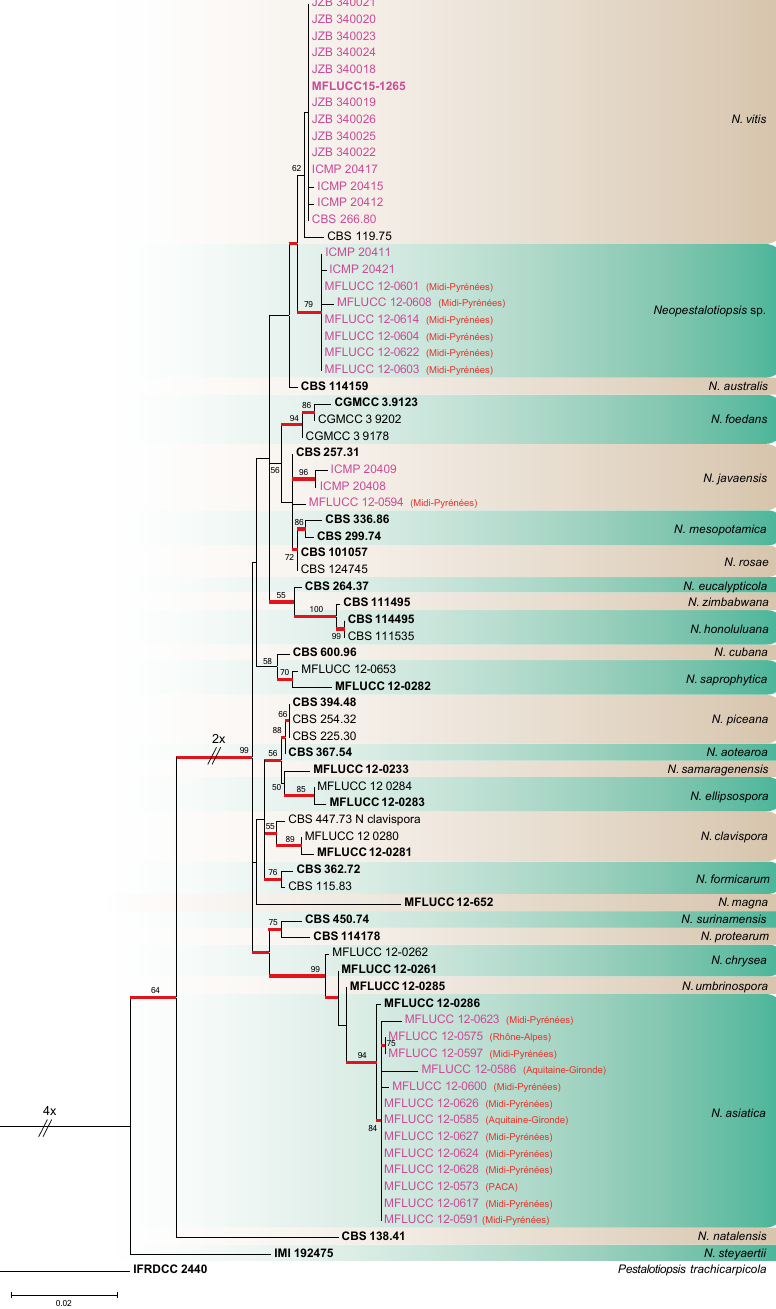
Figure 1. Consensus phylogram (50% majority rule) of 1,000 trees resulting from a RAxML analysis of the (ITS+TUB+TEF) alignment of the analysed Neopestalotiopsis sequences. Red-thickened lines indicate Bayesian posterior probabilities (PP) above 90% and RAxML bootstrap support values (MLB) above 50% are given at the nodes. Sequences derived from ex-type strains are printed in bold type, and isolates derived from grapevine are printed in magenta and followed by the place of origin in France. The species name is indicated to the right of each clade. The scale bar represents the expected number of changes per site. The tree was rooted to Pestalotiopsis trachicarpicola (IFRDCC